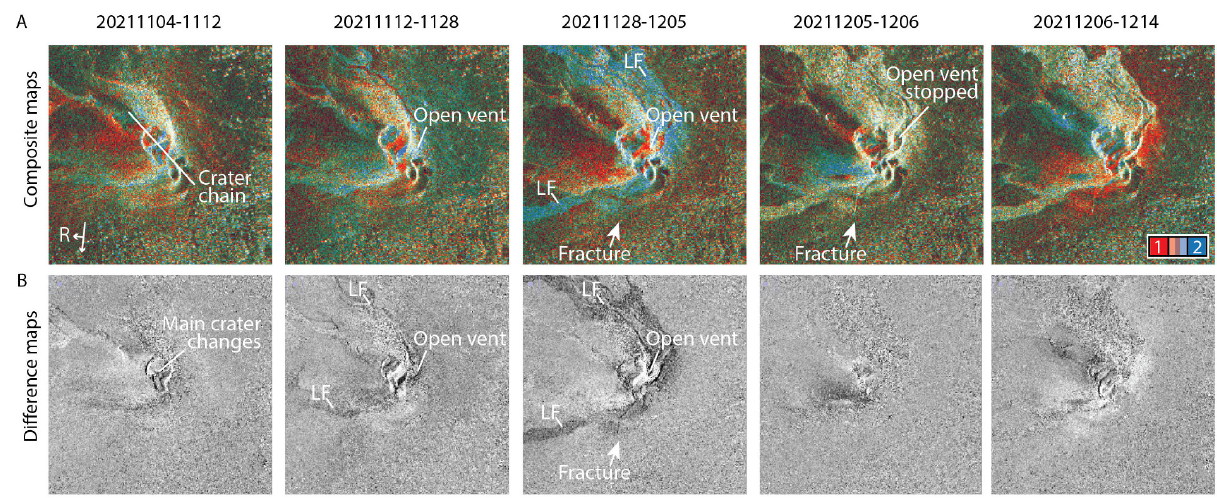
Figure 2: Satellite radar change analysis from image dataset acquired by COSMO-SkyMed (orbit H4 08D) just before and after the December 2021 fracturing event. [A] Composite maps of two consecutive radar images, the primary image is shown in red channel, the secondary image shown in blue channel, dates are provided above the images. [B] Radar image difference in gray scale, for the same dates. Analysis suggests fracture occurrence in early December 2021 (see also Supplementary Material 1) was associated with a shift in eruptive activity and new lava flows to the south and north side of the main crater row. Note the orientation of the fracture aligns with the open vent to the north. R stands for the satellite range direction, LF - new lava